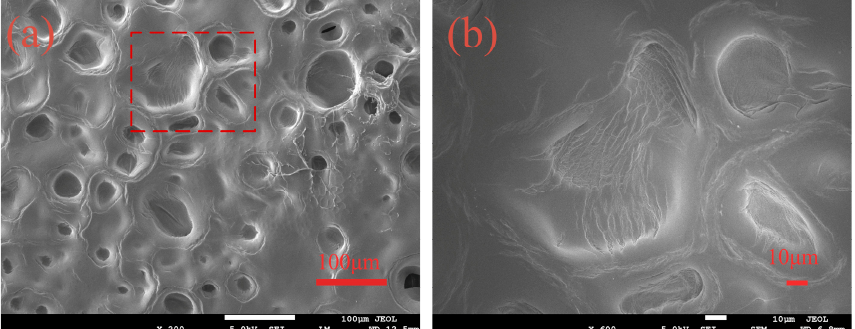
Figure 3. SEM image of hydrogels: ( a ) PAMC; ( b ) the partial enlarged detail of ( a ).